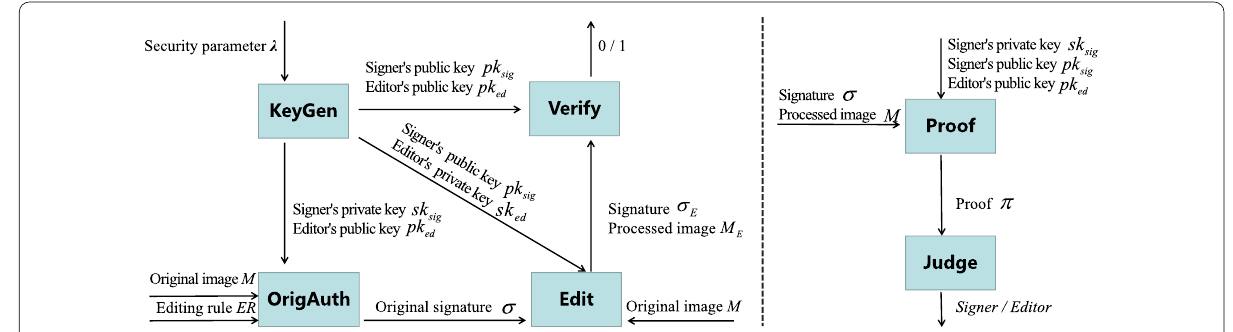
Fig. 3 Frame of image authentication scheme supporting verifiable image